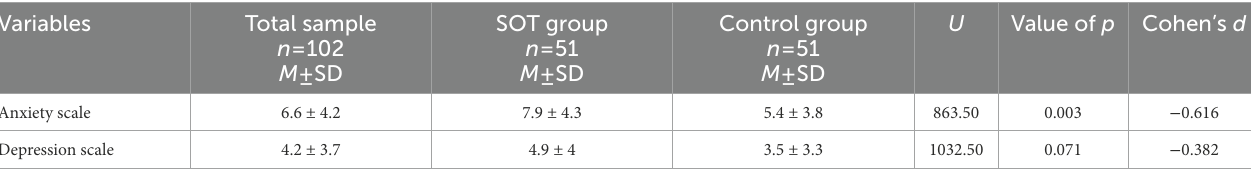
TABLE 3 Hospital Anxiety and Depression Scale